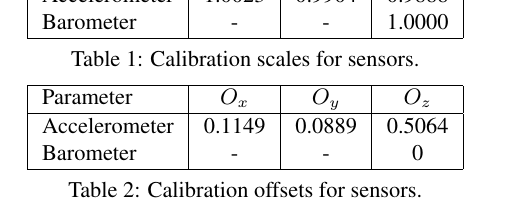
Table 1: Calibration scales for sensors.